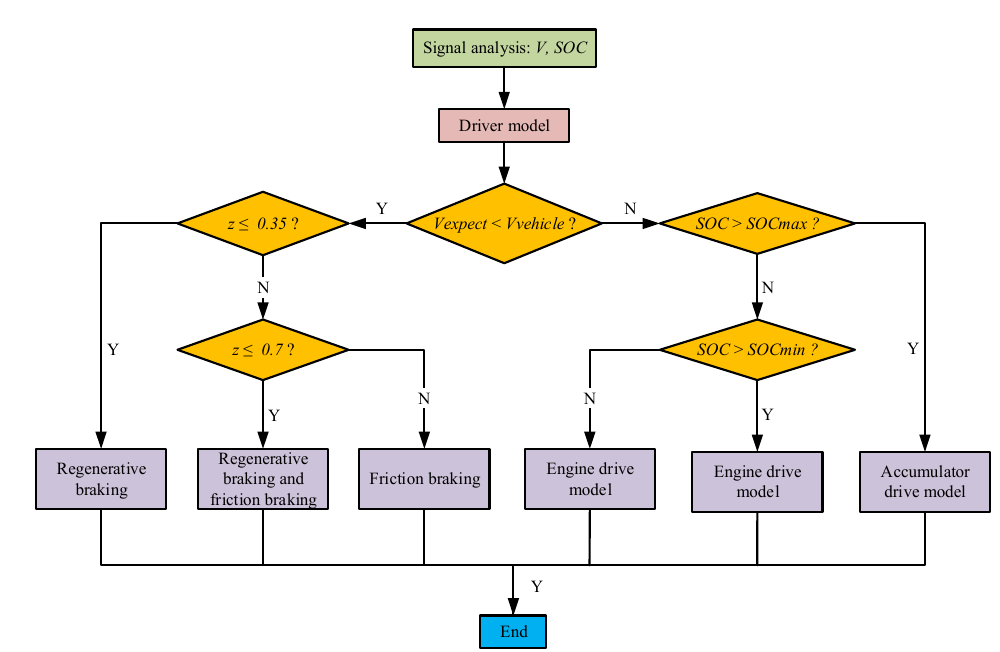
Figure 21. Control method of the wheel ‐ driven hydraulic vehicle [118].